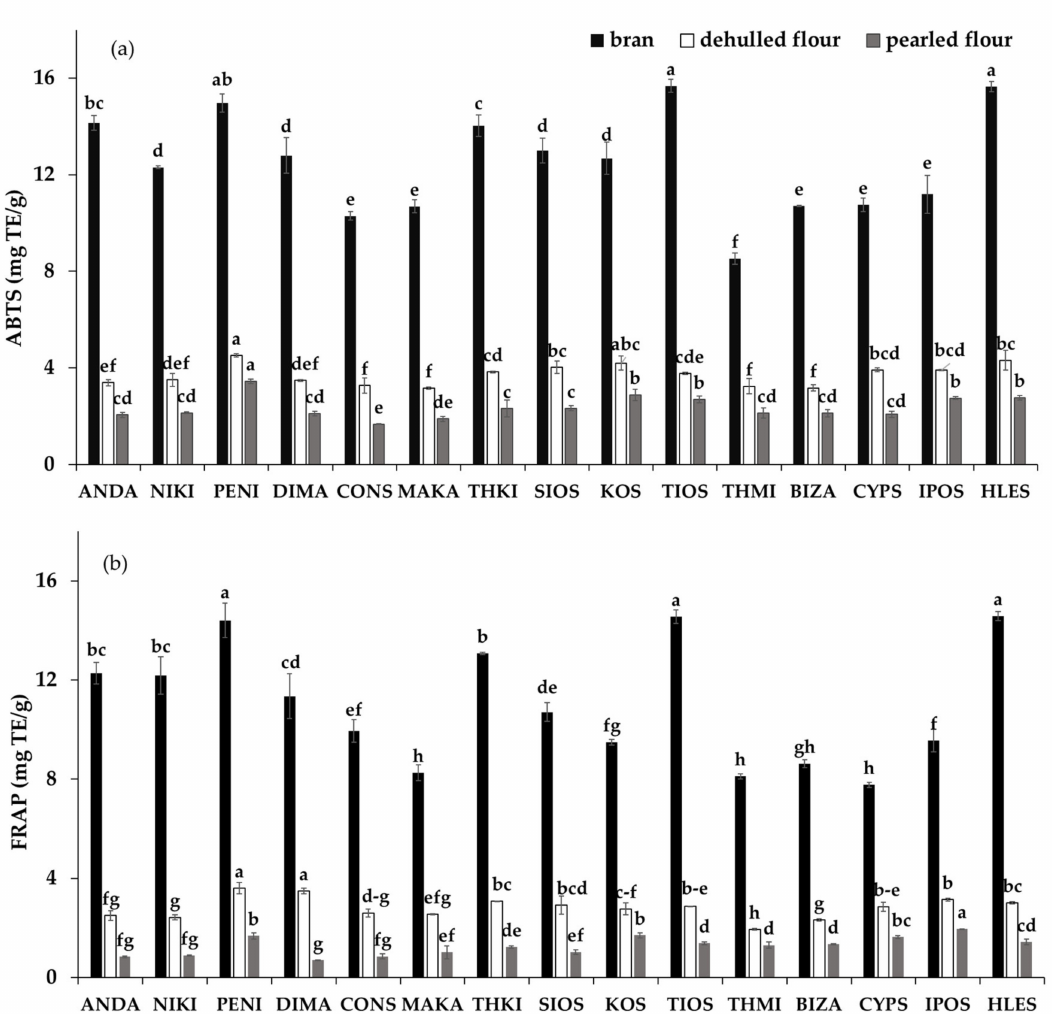
Figure 4. Antioxidant activity by ABTS ( a ) and FRAP tests ( b ) of fractions (bran, dehulled four, pearled flour) of barley cultivars. Bars with no letter in common are significantly di ff erent from each